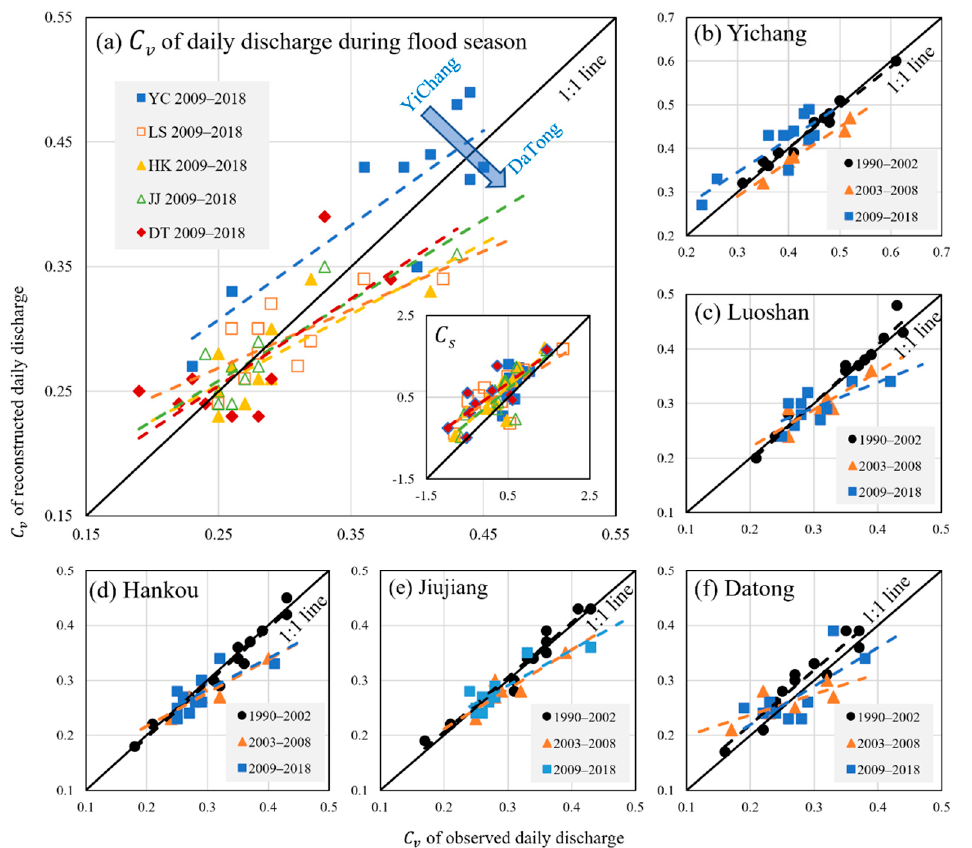
Figure 16. Comparison of the 𝐶 (cid:3049) and 𝐶 (cid:3046) of daily discharge during flood season between the five gauging stations. If points are above the 1:1 line, the 𝐶 (cid:3049) of reconstructed daily discharge is greater than the 𝐶 (cid:3049) of the observed daily discharge, and the TGD has reduced the 𝐶 (cid:3049) . In contrast, if points are below the 1:1 line, the 𝐶 (cid:3049) of the reconstructed daily discharge is less than the 𝐶 (cid:3049) of the observed daily discharge, and the TGD has increased the 𝐶 (cid:3049)